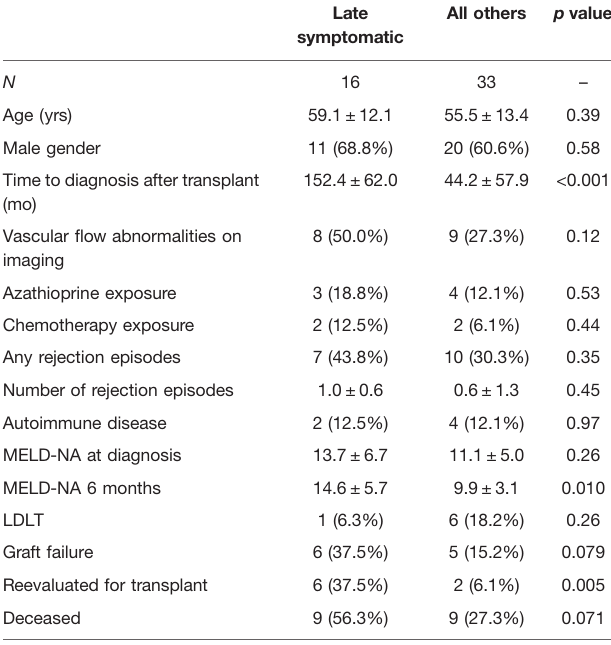
TABLE 2 | Late symptomatic patients vs all